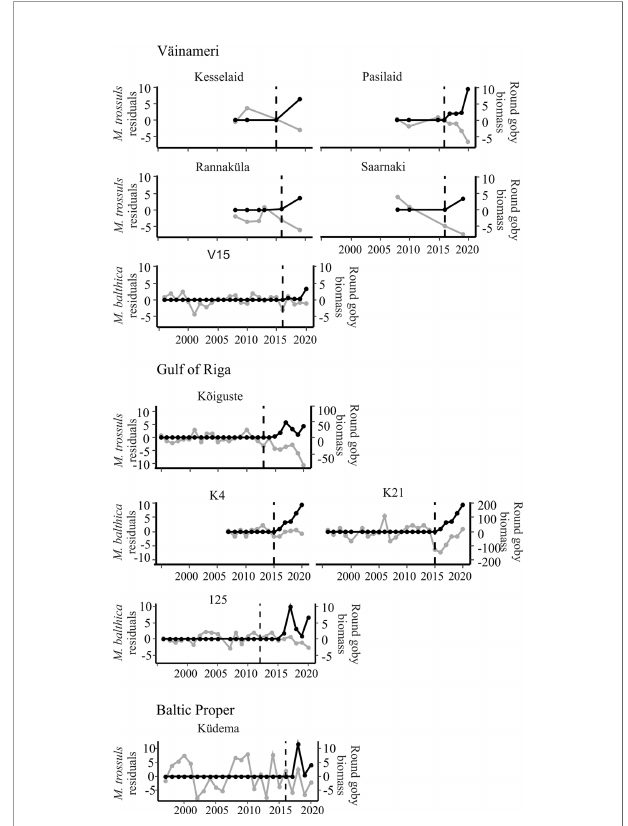
FIGURE 4 | Annual residuals (grey) (g dry weight m -2 ) and round goby biomass (black) (annual kg km -2 ) at stations in Väinameri, Gulf of Riga and Baltic Proper. Dashed vertical line indicates start of round goby invasion in each